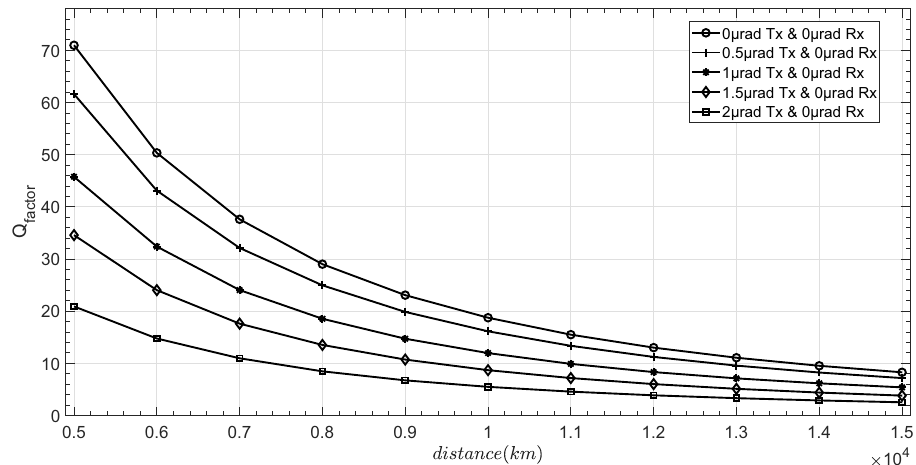
Figure 9: Quality factor ( Q factor ) as a function of distances between satellites for a di ff erent transmitter only pointing